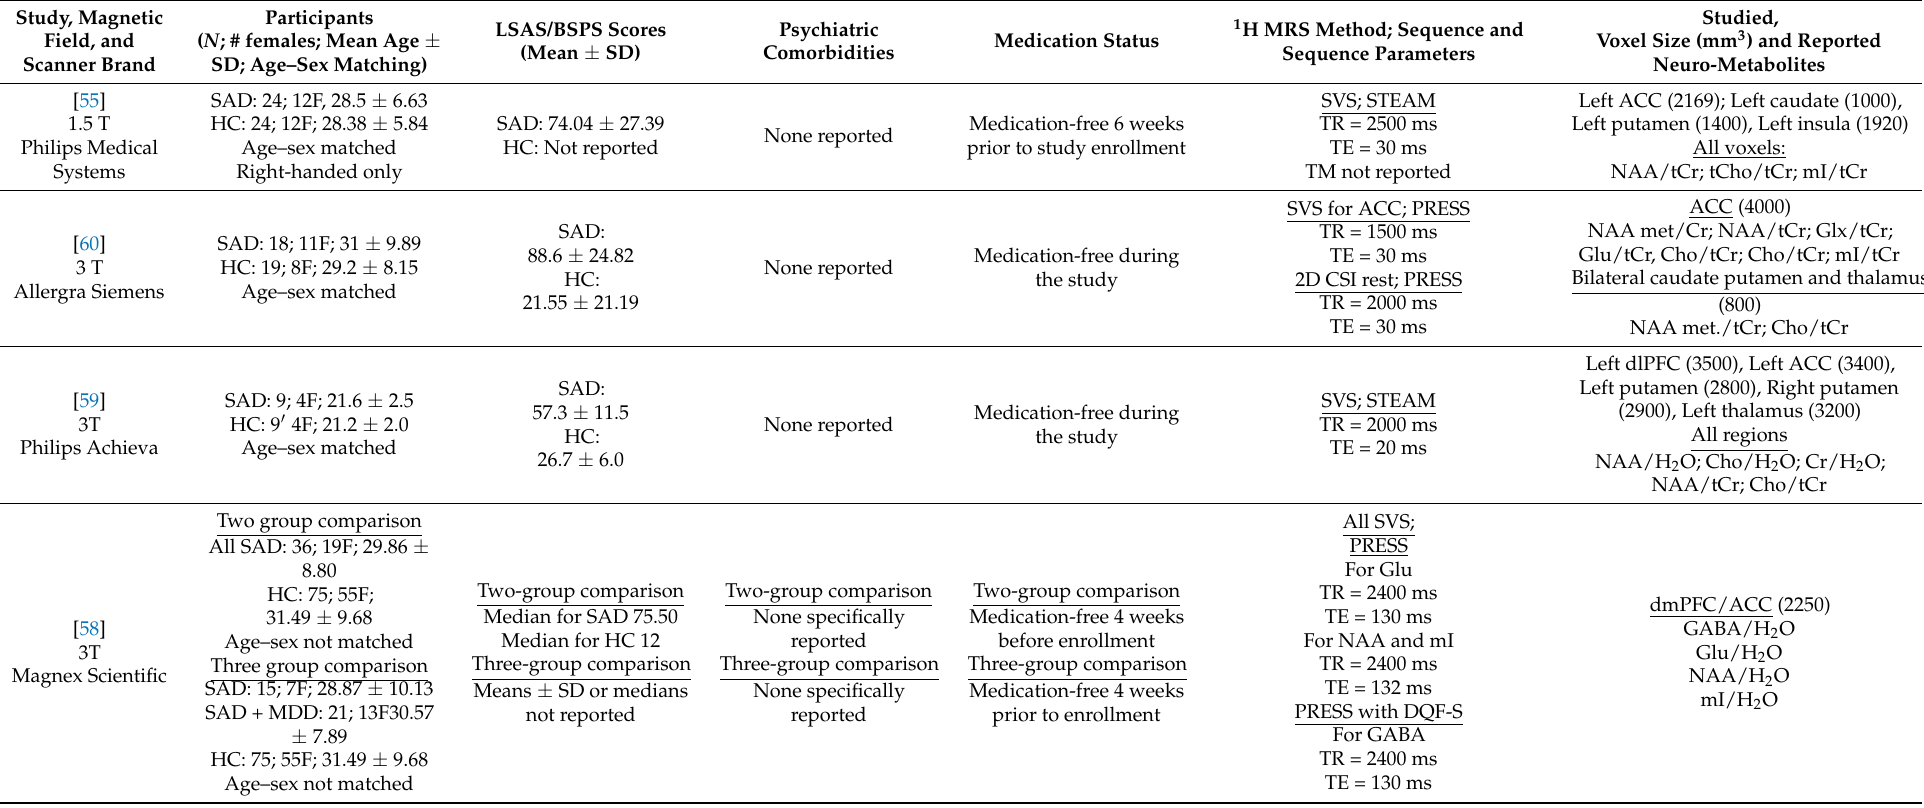
Table 1. Study demographic characteristics and 1 H MRS methods . Abbreviations: N , number of participants; F, females; #, number; SD, Standard Deviation; 1 H MRS, Proton Magnetic Resonance Spectroscopy; ROI, region of interest; mm 3 , cubic millimeters; T, Tesla; LSAS, Liebowitz Social Anxiety Scale; BSPS, Brief Social Phobia Scale; SAD, Social Anxiety Disorder; HC, Healthy Controls; PTSD, Post-Traumatic Stress Disorder; PD, Panic Disorder; MDD, Major Depressive Disorder; AD, Adjustment Disorder; MDE, Major Depressive Episode; DD, Dysthymic Disorder; SP, Specific Phobia; APD, Avoidant Personality Disorder; NAA metabolite, N-acetyl aspartate metabolite; tCr, total creatine metabolite; tCho, total choline; mI, myo-inositol; GABA, gamma-aminobutyric acid; Glu, glutamate; Gln, glutamine; Glx, glutamix; H 2 O, water; ms, milliseconds; 2D CSI, two-dimensional chemical shift imaging; CGM, cortical gray matter; SCGM, subcortical gray matter; WM, white matter; NCGM, non-cortical gray matter; V, ventricle; ACC, anterior cingulate cortex; dmPFC, dorsomedial prefrontal cortex; dlPFC, dorsolateral prefrontal cortex; OC, occipital cortex; TE, echo time; TR, repetition time; TM, mixed time; STEAM, Stimulated Echo Acquisition Mode; PRESS, Point Resolved Spectroscopy; DQF-S, Double-Quantum and Filter-Selective Editing Technique for Refocusing of the GABA Signal; SNR, signal-to-noise